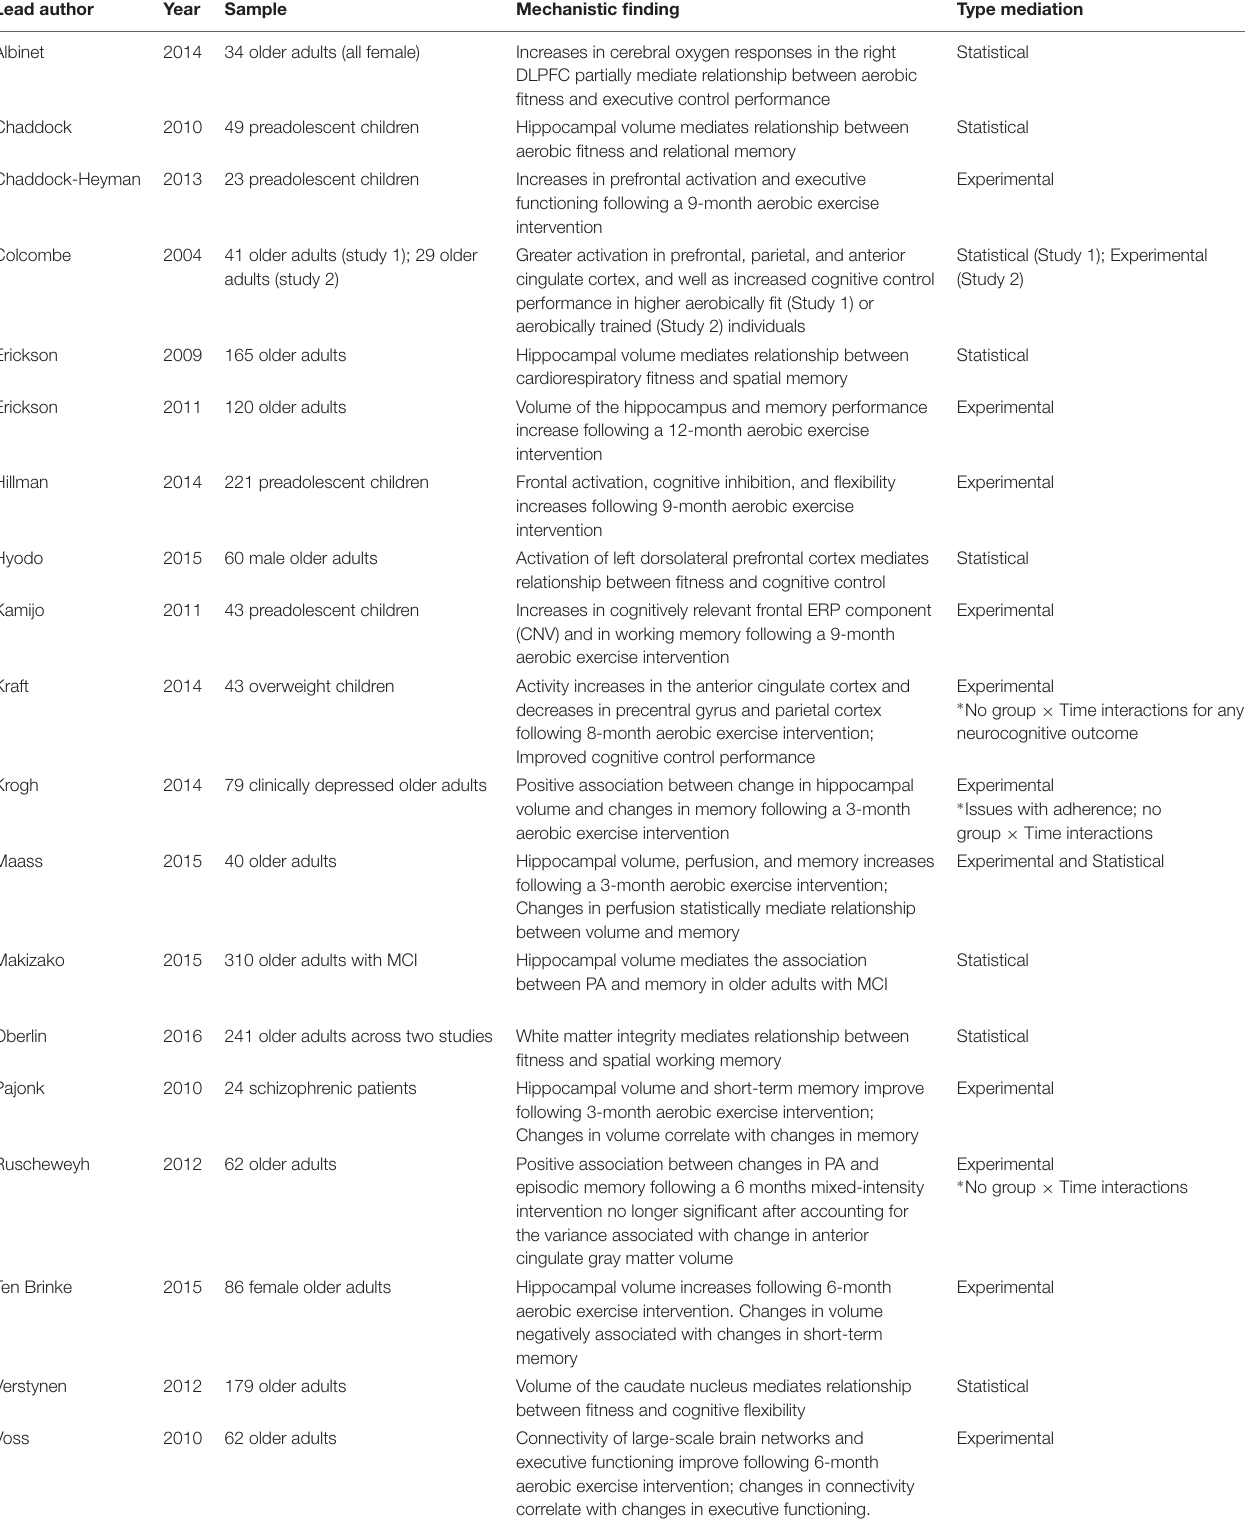
TABLE 1 | Evidence for mechanisms of PA at Level 2 of